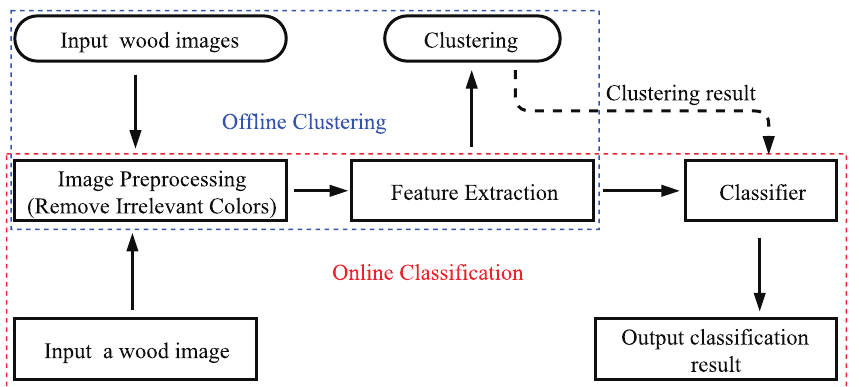
Figure 5. The framework of the color classification of wooden